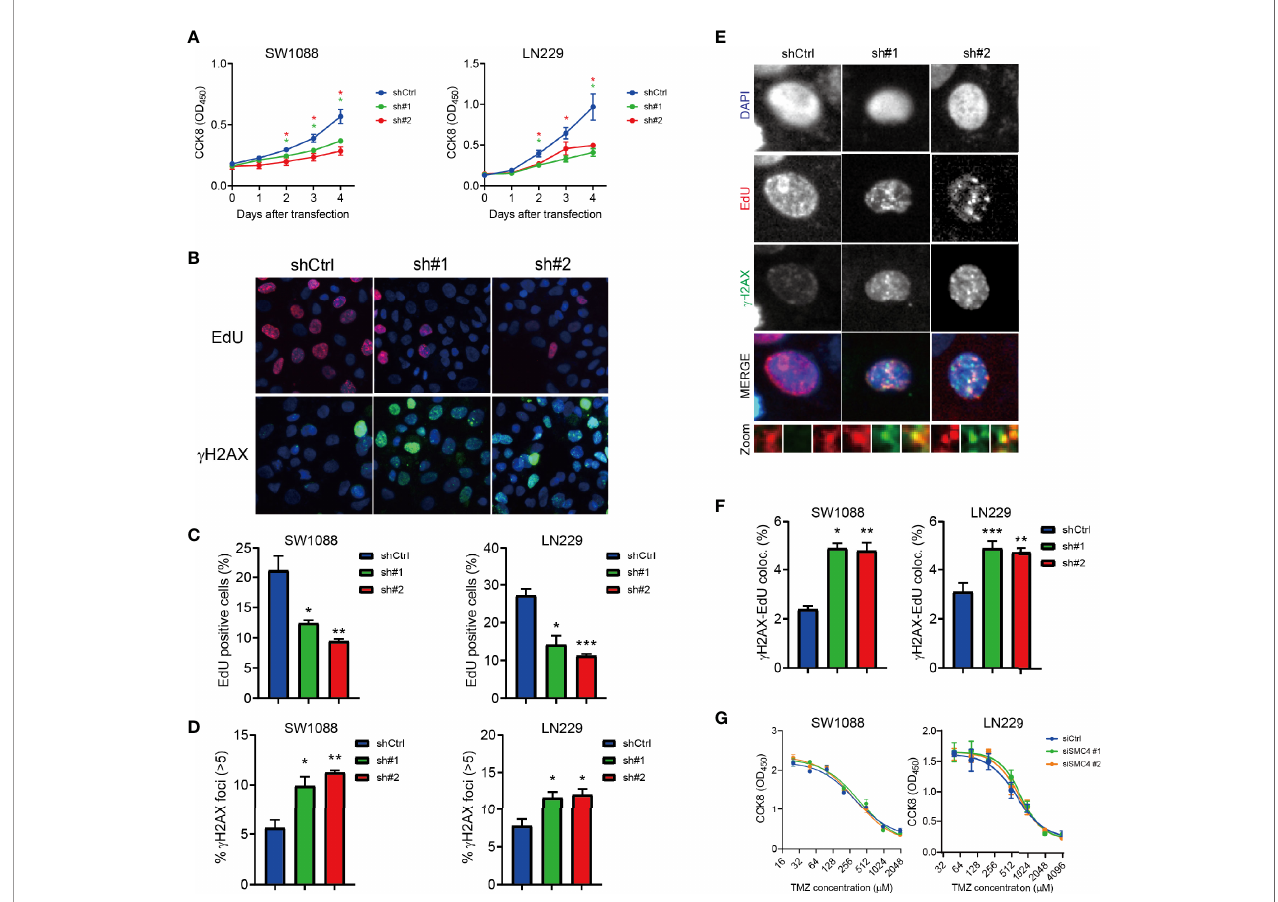
FIGURE 5 | (A) Proliferation assay showing reduced proliferation of SMC4 depleted SW1088 and LN229 cells with Cell Counting Kit 8 (CCK8). OD 450 was measured to quantify cell number in each group. Results from 3 different experiments. (B – D) Typical fi gures (B) and quanti fi cation (C, D) of the EdU staining ( B , the top panel and C ) and g H2AX staining ( B , the bottom panel and D ) in the control or SMC4 depleted SW1088 and LN229 cells. EdU (red) and g H2AX (green) were detected with immuno fl uorescence. Result from 3 different experiments. (E, F) Typical fi gures (E) and quanti fi cation (F) of EdU- g H2AX colocalization in the control or SMC4 depleted SW1088 or LN229 cells. EdU (red) and g H2AX (green) were detected with immuno fl uorescence. Results from 3 different experiments. (G) Dose- response analysis comparing the sensitivity of SMC4-depleted SW1088 and LN229 cells to temozolomide (TMZ) after 3 days with CCK8. OD 450 was measured